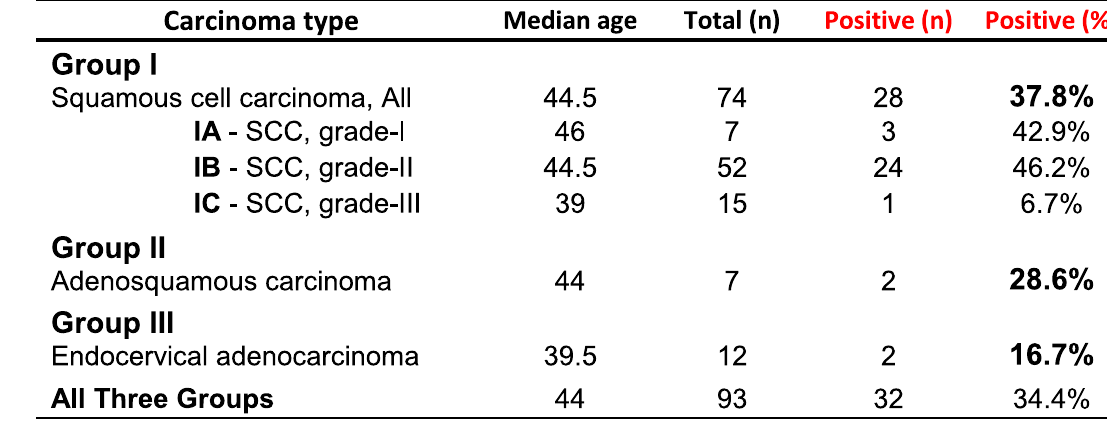
Reddy et al. Diagnostic Pathology (2017)